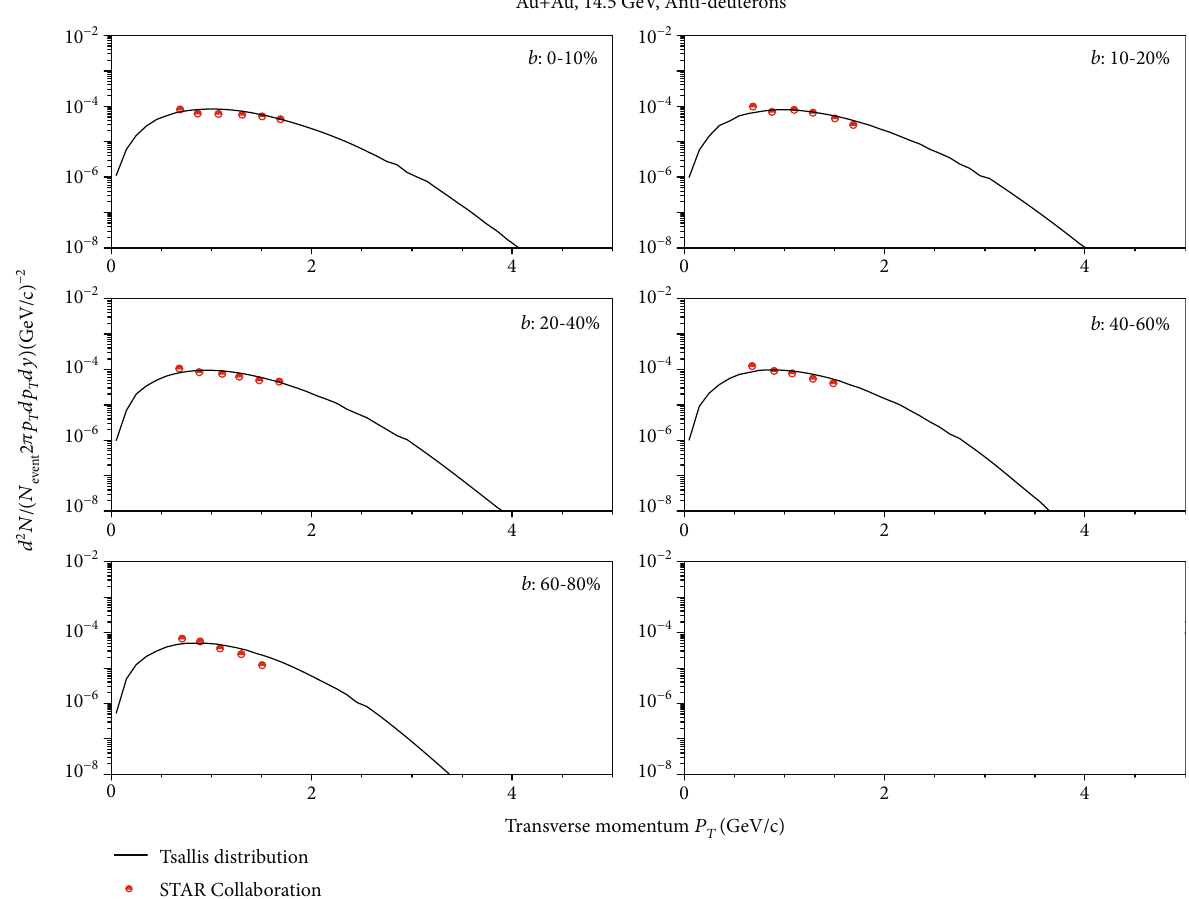
p ffiffiffiffiffiffiffi = 14 : 5 GeV for 0-10%, 10-20%, 20-40%, 40-60%, and s NN